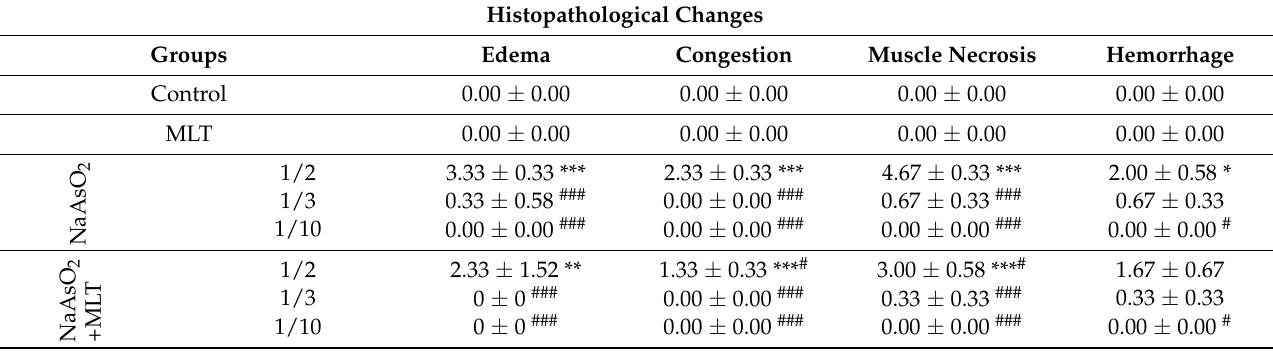
Table 4. Histopathological